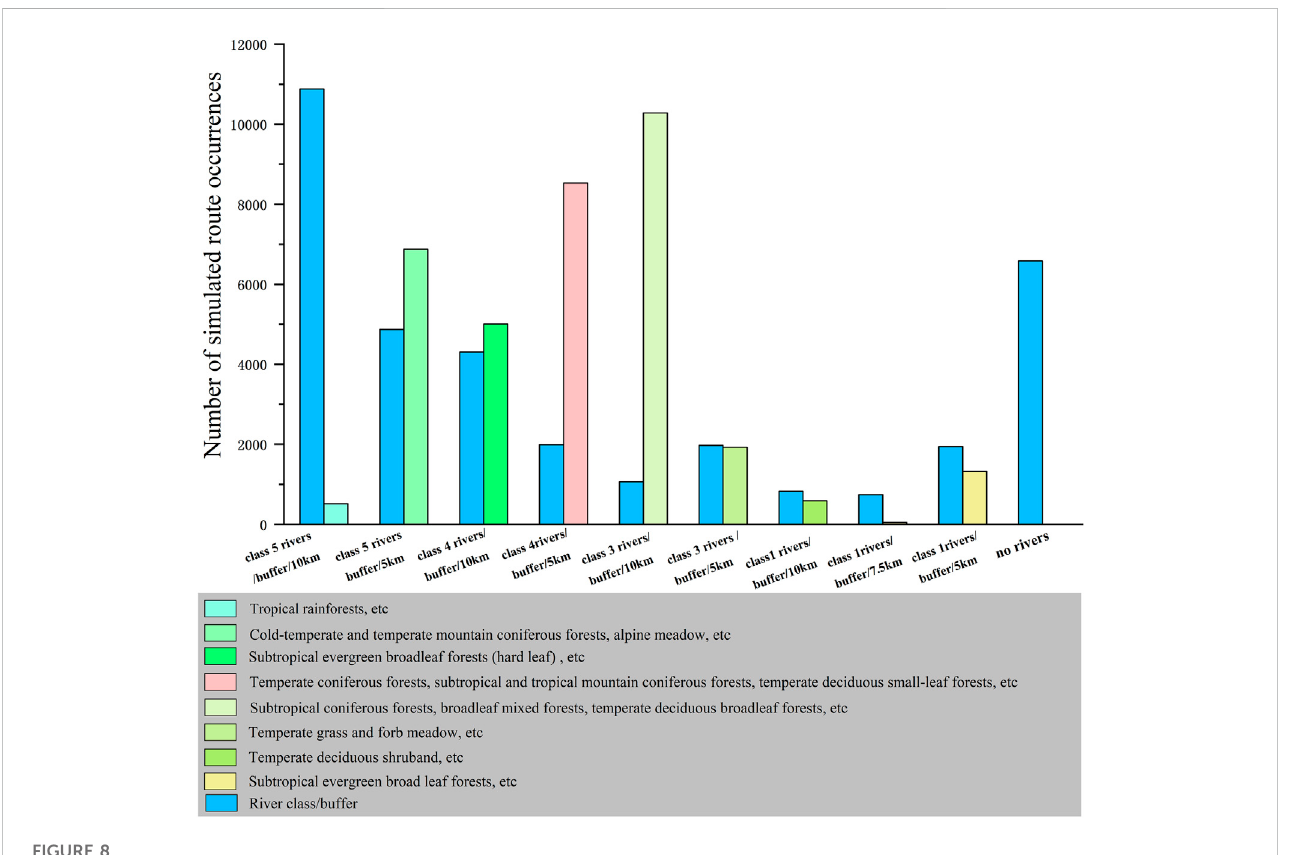
FIGURE 8 River and vegetation types associated with simulated Neolithic – Bronze Age exchange